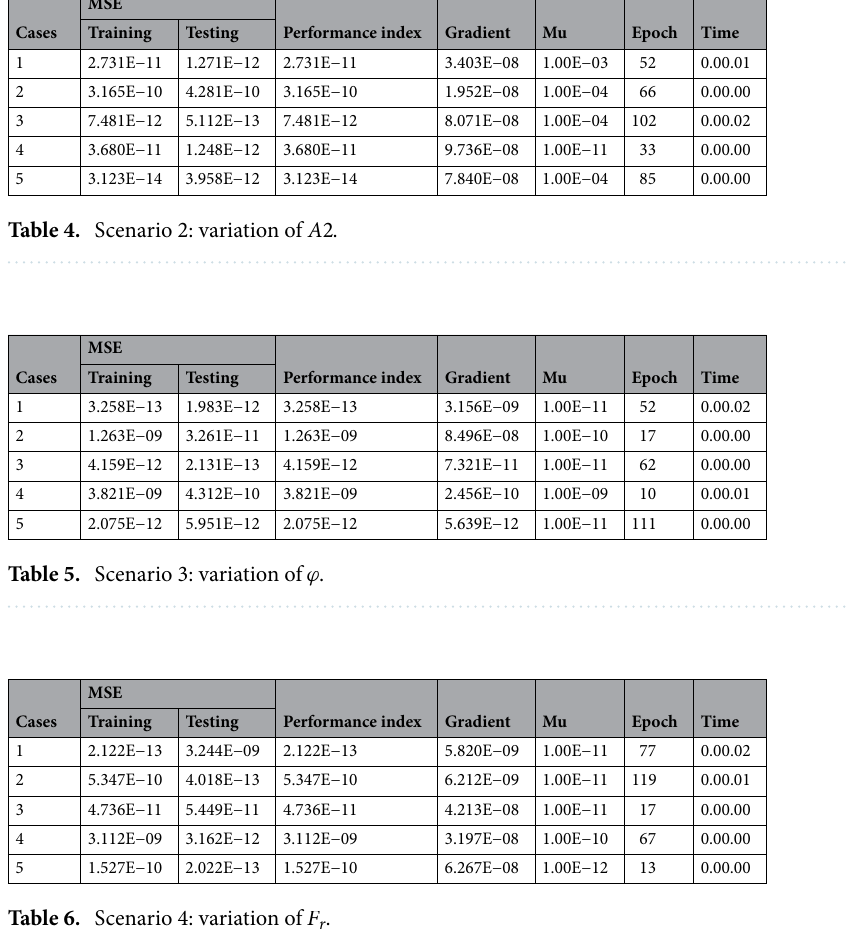
Table 6. Scenario 4: variation of F r .